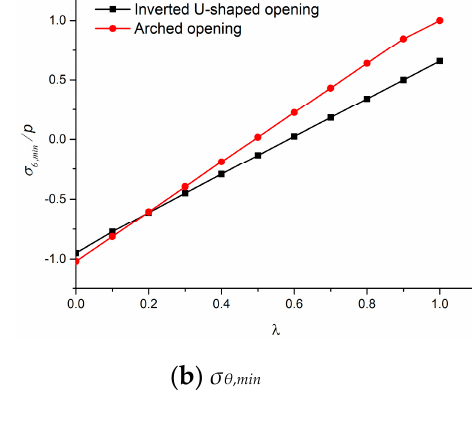
− σ θ , min ) versus λ